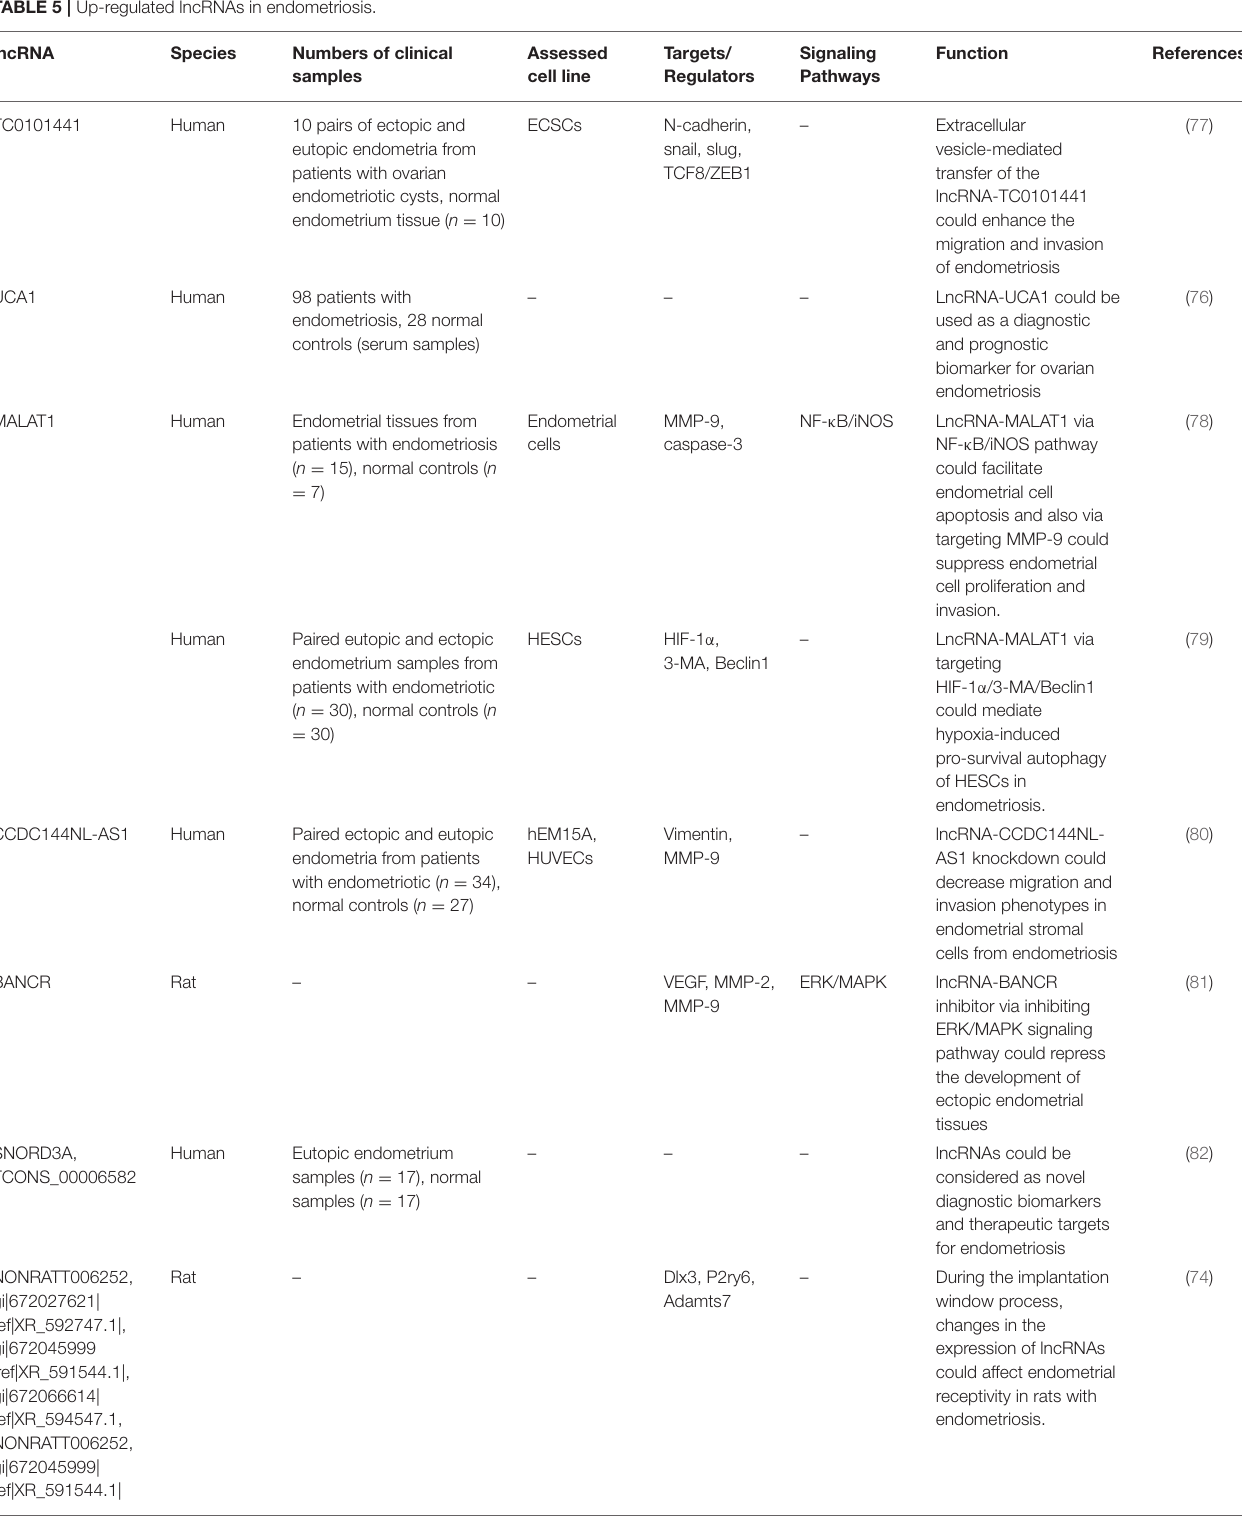
TABLE 5 | Up-regulated lncRNAs in